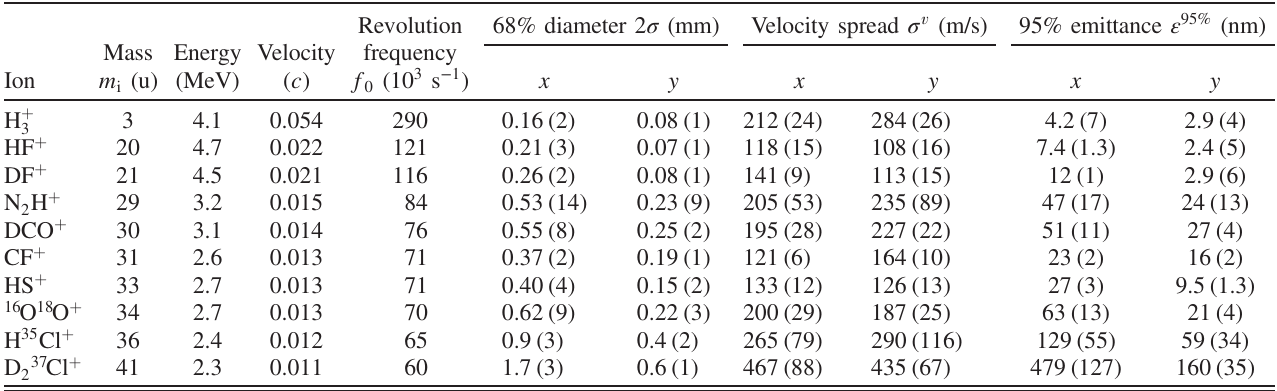
TABLE II. Ion beam properties after electron cooling. Equilibrium beam sizes, velocity spreads and final emittances are derived from the measured steady-state envelope sizes ˆ σ f of the neutral-product beams at the particle detectors using Eqs. (3), (17) and